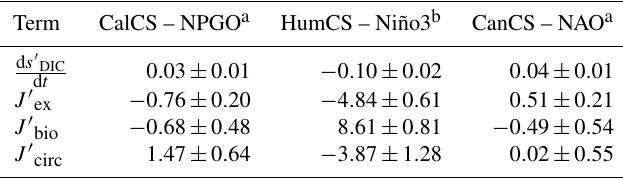
Table 3. Regression coefficients between the given EBUS and climate index for anomaly time series of the estimated contributions toward the s DIC tendency integrated over the upper 100m and the total surface area of the system, as in Eq. (5).